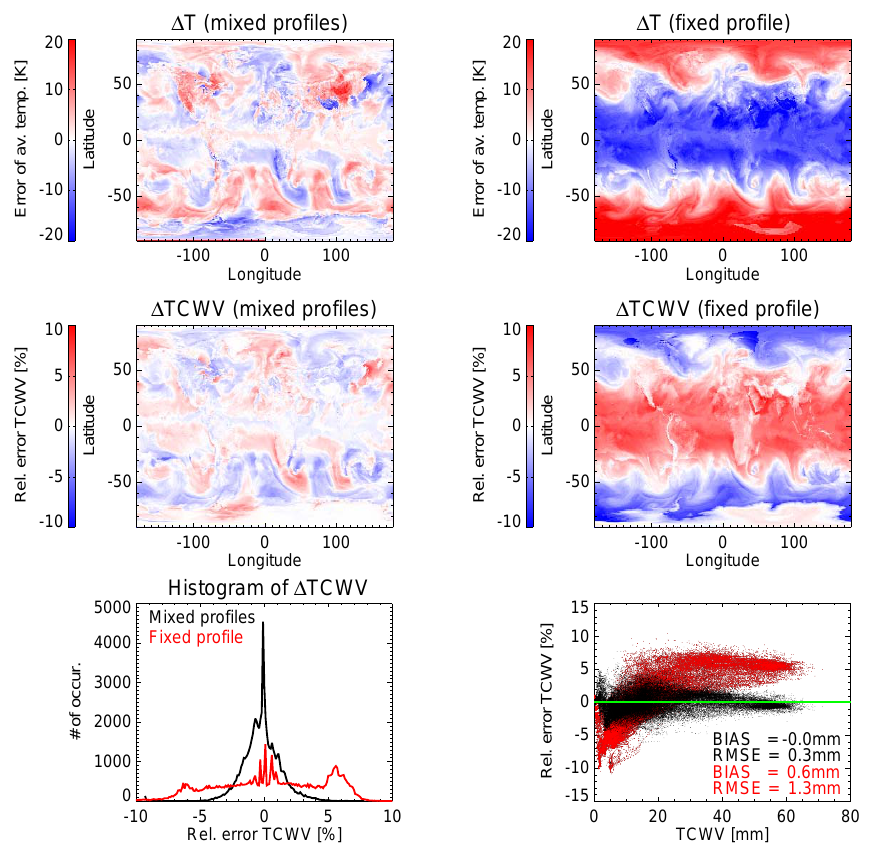
Fig. 1. Effect of temperature profile on TCWV retrieval: top panels show deviation of assumed average temperature in humid layer from the truth, middle panels show the resulting deviation of derived TCWV. Left panels represent the case of parametrizing the temperature profile with the surface temperature and mixing standard profiles accordingly. The right panels represent the assumption of a globally constant temperature profile (US standard). Bottom panels show global histograms of relative error and its dependency on TCWV, including both land and ocean